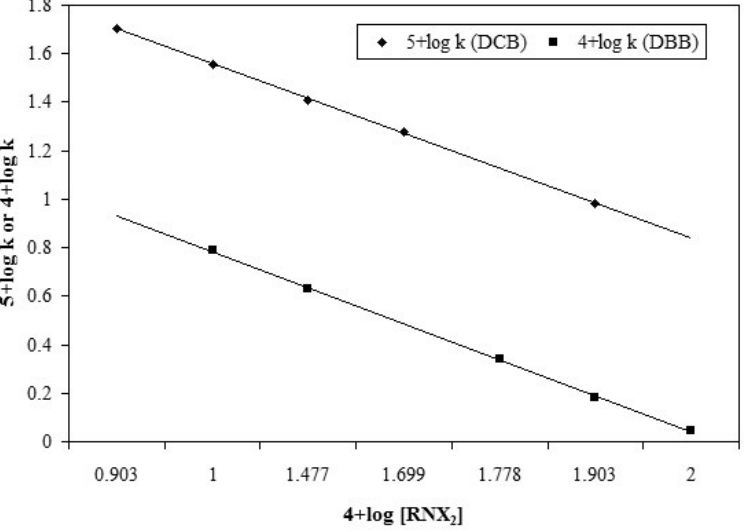
Figure 1. Plot of 4+logk (DBB) or 5+logk (DCB) versus 4+log [RNX 2